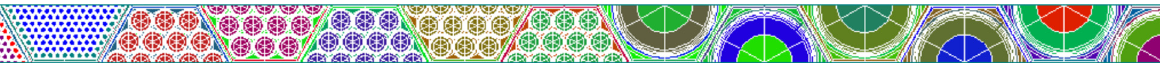
Fig. 14. Traverse model for the calculation of the cross sections re fl ector and the neutron shielding (to the